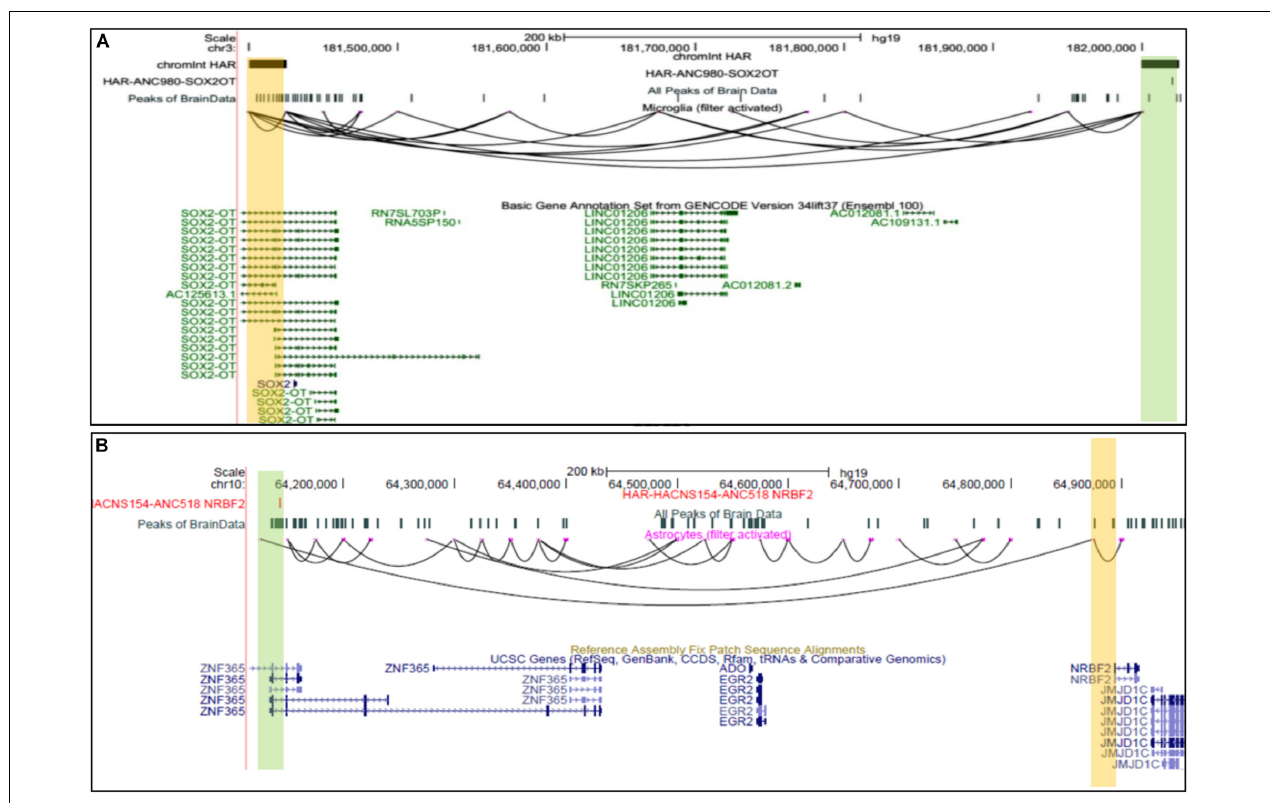
FIGURE 5 | UCSC browser snapshots for genes connected to Human accelerated elements (HARS). (A) The UCSC browser snapshot, showing an interaction estimated to exist between a genomic bin containing a human-accelerated-region (HAR) and promoter of SOX2OT , in microglia. (B) The snapshot showing an interaction between a region with HAR and a promoter of NRBF2 gene which is associated with Alzheimer’s disease.